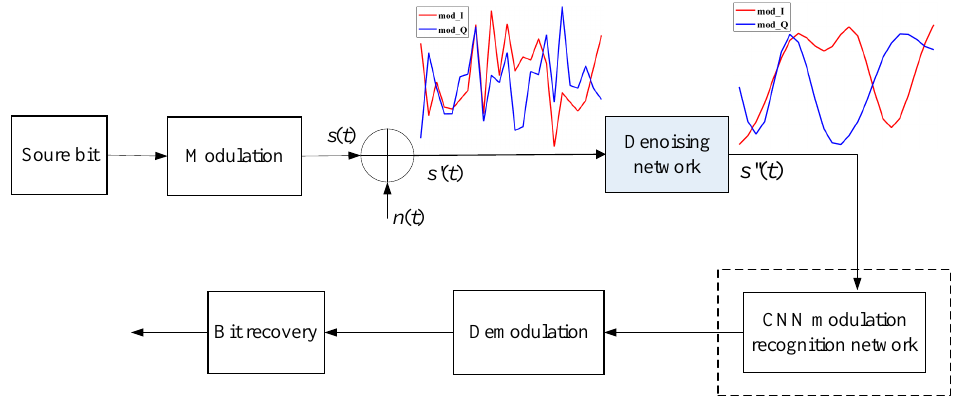
Figure 1. Communication system